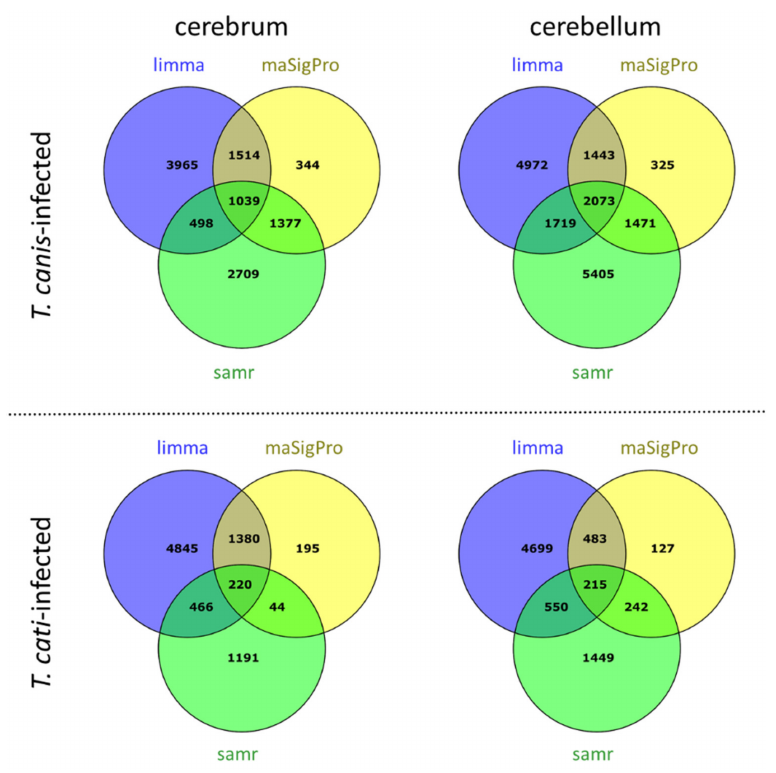
Figure 2. Differentially transcribed genes identified in cerebra and cerebella of T. canis - and T. cati - infected mice over the course of